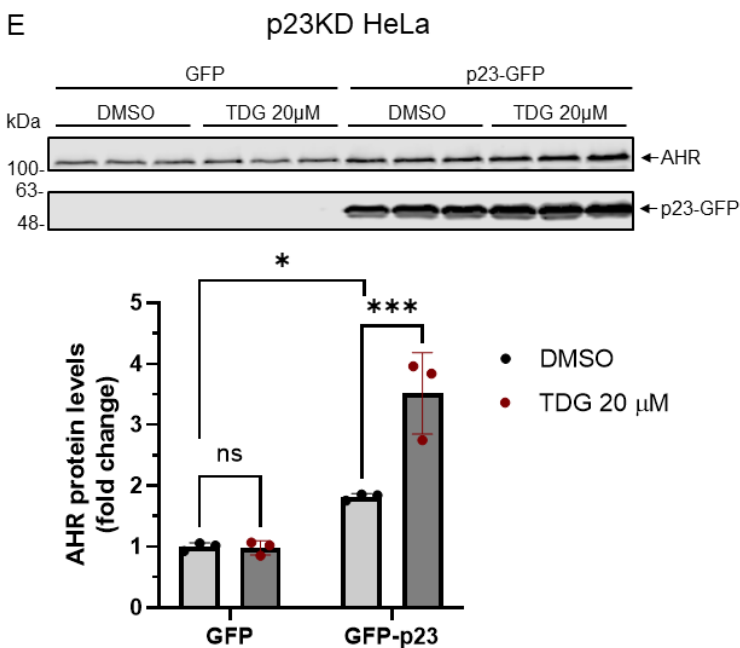
Figure 7. Down-regulation of p23 in HeLa cells causes AHR not responsive to GSK3 β regulation. ( A ) AHR protein levels were not altered by 8-h treatment of 10 µ M or 20 µ M TDG in p23 stable knockdown (p23KD) HeLa cells. Treatment of 40 µ M TDG increased AHR protein levels to 1.3-fold. The images are representative of the replicate data (means ± SD, n = 3, ** p < 0.01, ns represents not significant). DMSO group (treated for 8 h) was arbitrarily set as one (with no error bar) for data normalization. One-way ANOVA with Dunnett multiple comparisons test was performed to determine statistical significance. ( B ) Treatment of 5 mM LiCl for 6 h did not alter AHR protein levels in p23KD HeLa cells. The images are representative of the replicate data (means ± SD, n = 3, ns represents not significant). No LiCl (no treatment) group was arbitrarily set as one (with no error bar) for data normalization. Unpaired t -test with Welch’s correction was used to determine the statistical significance. ( C ) β -catenin protein levels decreased while AHR protein levels showed no significant difference after transient expression of HA-GSK3 β (72 h after transient transfection) in p23KD HeLa cells. The images are representative of the replicate data (means ± SD, n = 3, * p < 0.05, ns represents not significant). No plasmid group (NP) represents cells undergoing the same transient transfection protocol without the HA-GSK3 β expressing plasmid and was arbitrarily set as one (with no error bar) for data normalization. Unpaired t -test with Welch’s correction was used to determine the statistical significance. ( D ) β -catenin protein levels increased in p23KD HeLa cells after treatment of 5 mM LiCl for 6 h. The images are representative of the replicate data (means ± SD, n = 3 in one experiment, which was repeated once with similar results, *** p < 0.001). No LiCl (no treatment) group was arbitrarily set as one for data normalization. Unpaired t -test was used to determine the statistical significance. ( E ) p23KD HeLa cells were transiently transfected with the plasmid expressing GFP or GFP-p23. Transient expression of GFP-p23 caused AHR protein levels to increase when cells were treated 20 µ M TDG for 8 h. The images are representative of the replicate data (means ± SD, n = 3 in one experiment, which was repeated once with similar results, * p < 0.05, *** p < 0.001, ns represents not significant). DMSO treatment group of GFP-transfected cells was arbitrarily set as one for data normalization. Two-way ANOVA with Sidak multiple comparisons test was performed to determine statistical significance. For A to E, each Western lane contained 30 µ g of whole-cell lysate. Data in A were normalized by β -actin (as shown) whereas the rest of the data were normalized by total protein